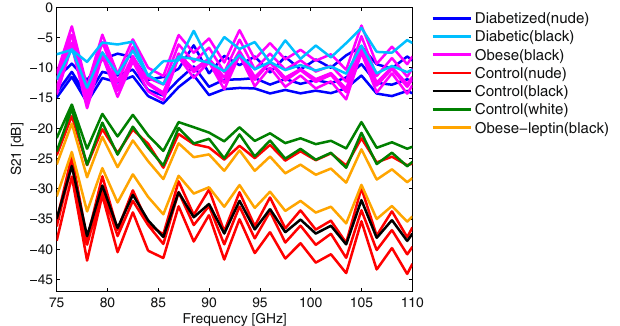
Figure 5. Amplitude of the transmission coefficient S(2, 1) versus frequency for the different mice strains.